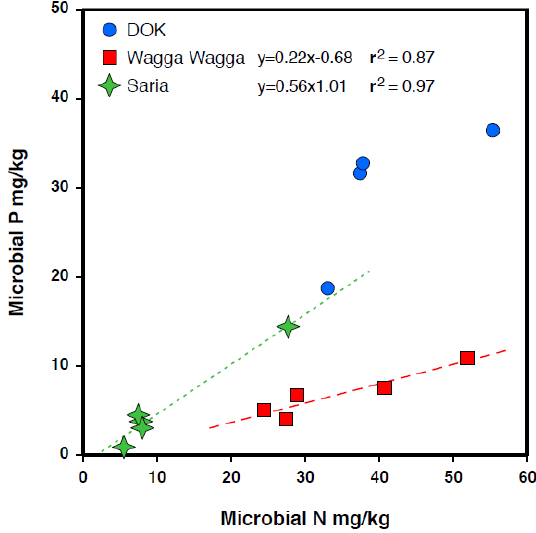
Figure 5. Relationship between soil microbial N and microbial P concentrations in the three field experiments. Points in blue rep- resent DOK, points in red represent Wagga Wagga, and points in green represent Saria. The relationships in Saria and Wagga Wagga are statistically significant at p <